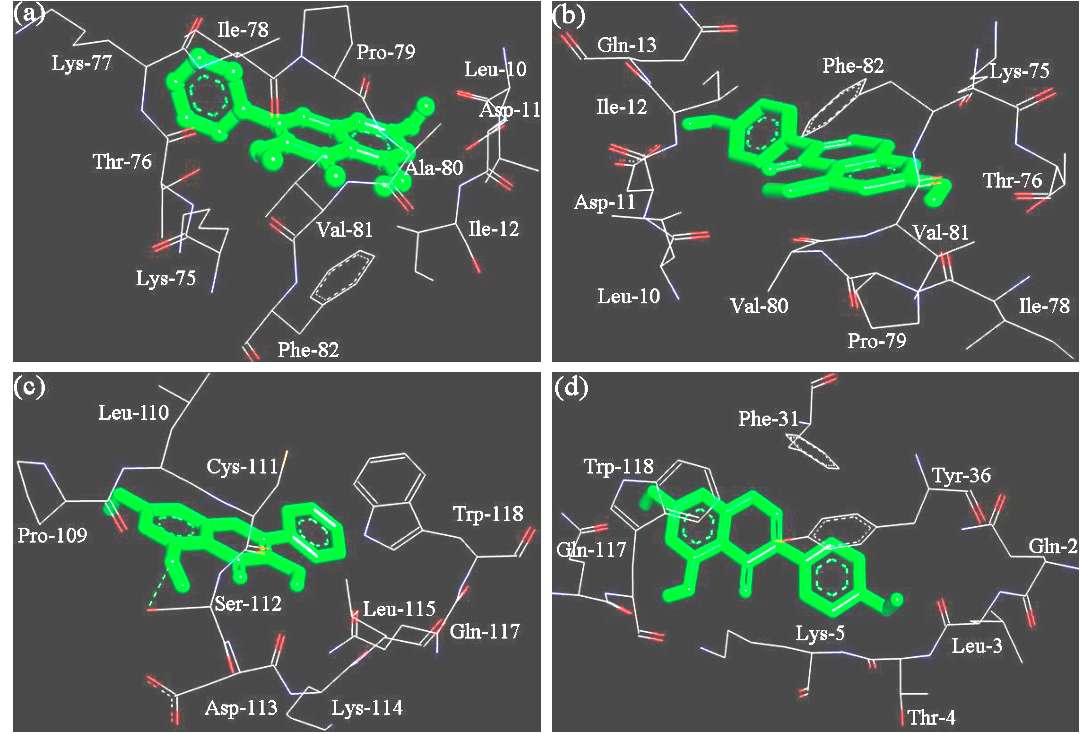
Figure 4. The docked sites for the non ‐ covalent binding of β‐ lactoglobulin ( a, b ) or α‐ lactalbumin ( c, d ) with galangin ( a, c ) or genistein ( b, d ). Hydrogen ‐ bonds are shown by green dashes.